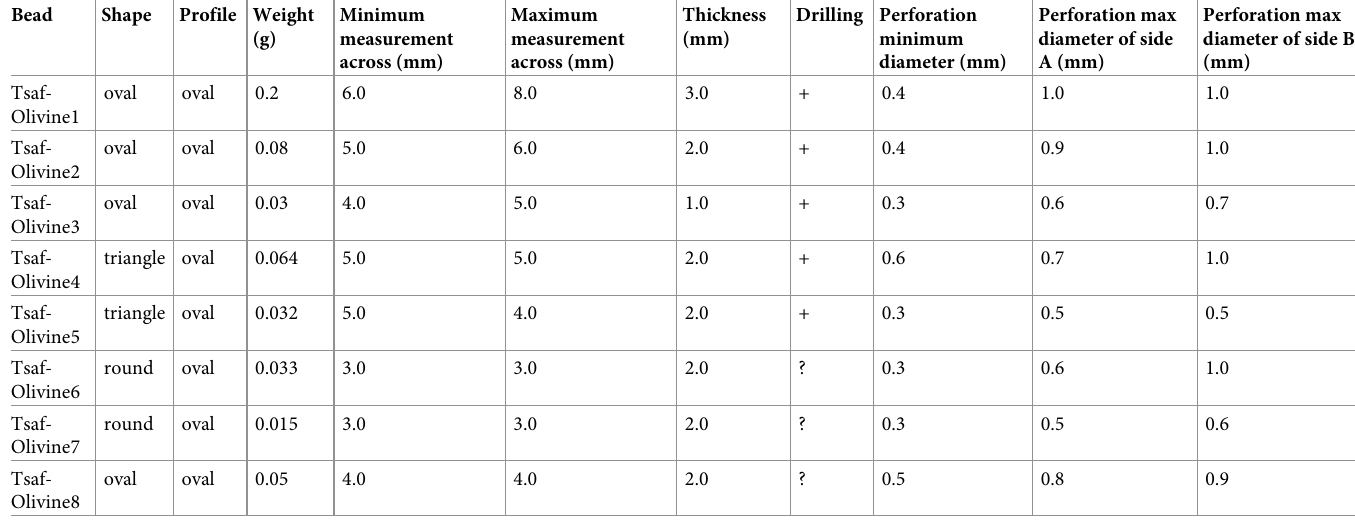
Table 2. The characteristics and properties of the olivine